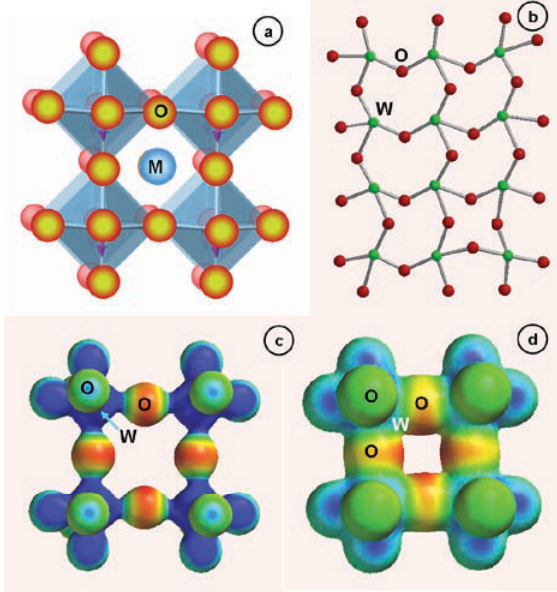
Figure 8. WO structure: (a) ideal tungsten bronze MWO 3 (b) amorphous structure; (c,d) electrostatic potential distribution mapped on electron density surface with d = 0.02 (c) and d = 0.002 (d); color coded potential: from high – blue, to low –